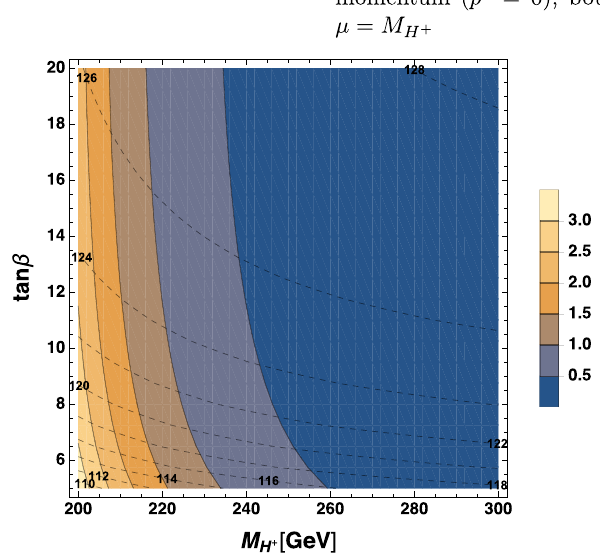
Fig. 8 The dependence of the size of the CP-odd component on M H + and tan β is shown for a scenario M s = 30 TeV, ϕ M 120 ◦ , and | A | = | μ | = 3 M s . The color coding gives the percentage